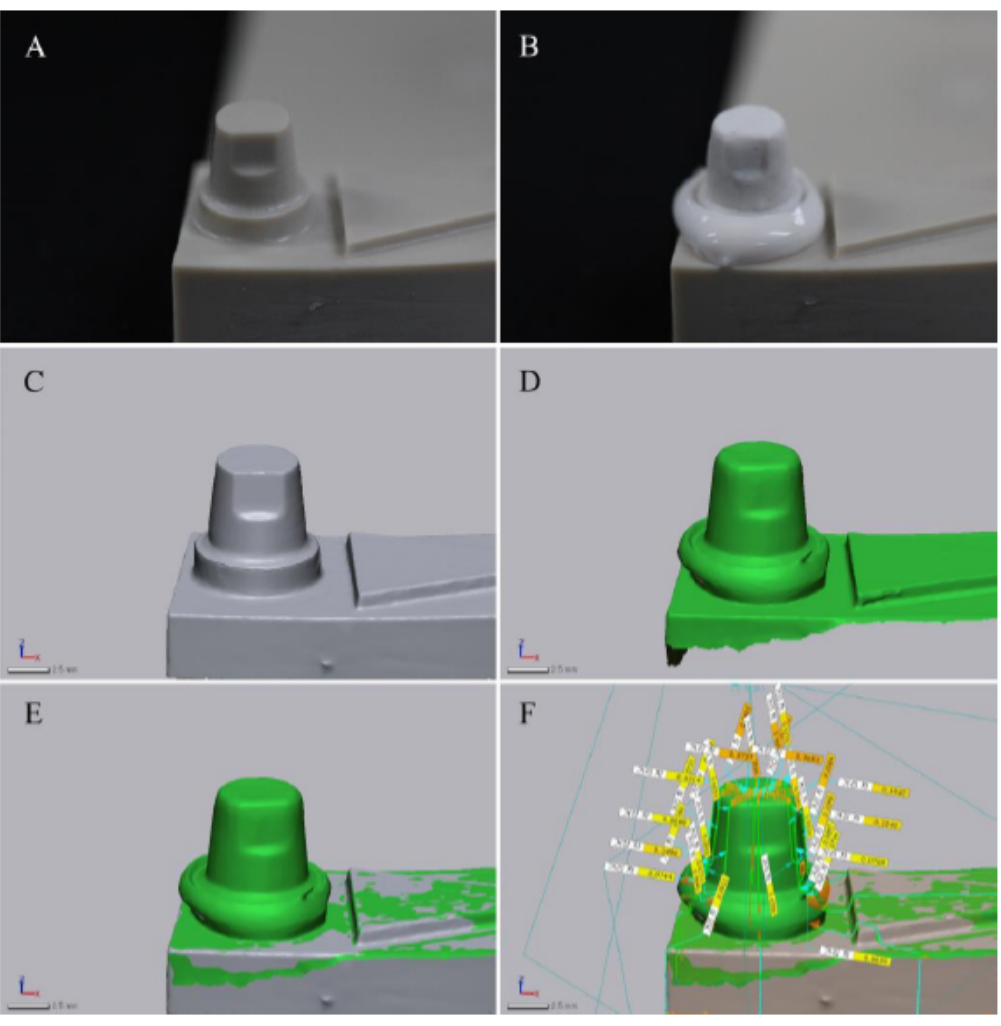
Figure 3. Procedure for measuring marginal and internal fit. ( A ) A fabricated model without silicone material. ( B ) A fabricated model with silicone material. ( C ) A scanned model without silicone material. ( D ) A scanned model with silicone material. ( E ) Superimposition of ( B , D ). ( F ) Marginal and internal fit measurements on virtual planes by measuring the thickness of the replicated silicone material.